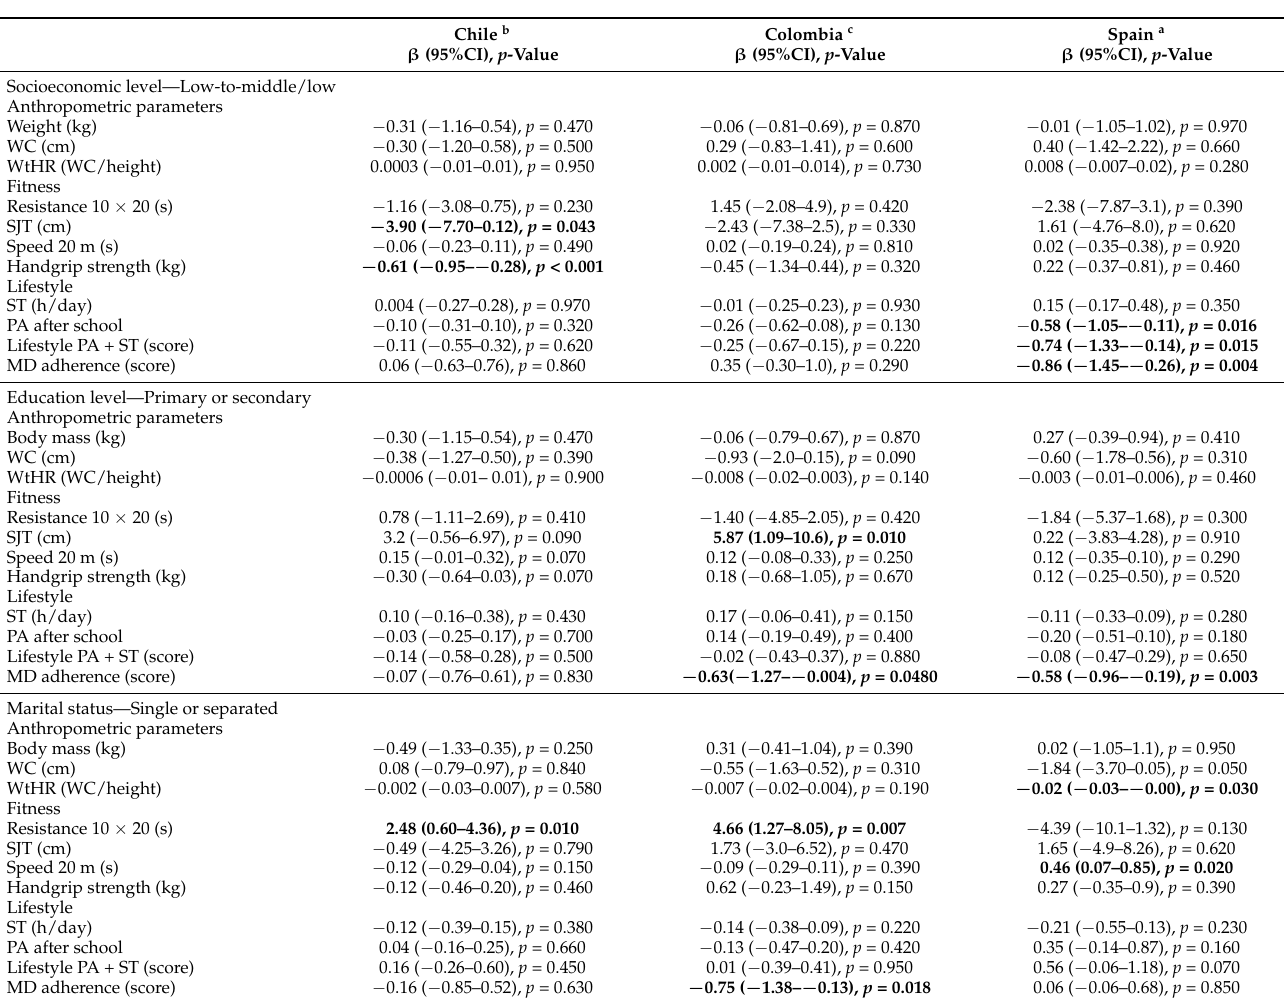
Table 3. Association of parental sociodemographic status with anthropometric, fitness, and lifestyle parameters in children according to